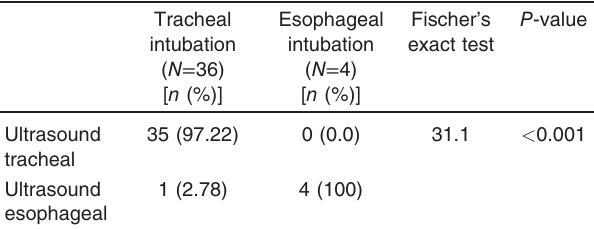
Table 4 Time required for confirmation of endotracheal tube position